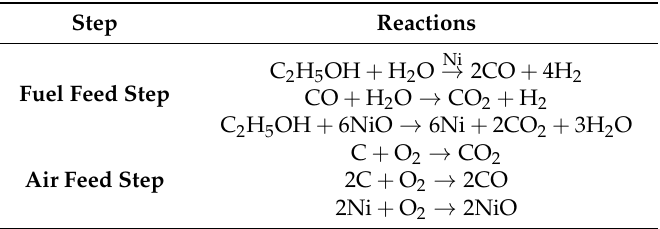
Table 1. Reactions during fuel feed step and air feed